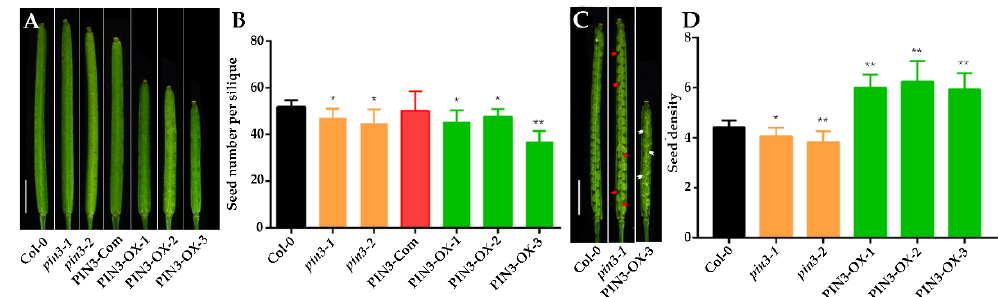
Figure 4. Siliques, seed number per silique (SNS) and seed density (SD) of wild type, pin3 , PIN3-Com (complementation lines) and PIN3-OX (overexpression lines). ( A ) The silique of Col-0, pin3-1 and pin3-2 mutants, PIN3-Com, and PIN3-OXs (Bar = 2mm). ( B ) SNS of Col-0, pin3-1 and pin3-2 mutants, PIN3-Com, and PIN3-OXs. ( C ) Dissected siliques of Col-0, pin3-1 and PIN3-OX-3. Red and white arrows indicate sparsely arranged and crowdedly arranged seed region, respectively (Bar = 2 mm). ( D ) SD of wild type, pin3 and PIN3-OX. “**” indicates statistical significance at p -value < 0.01, “*” indicates statistical significance at p -value < 0.05, p -value determined by Student’s t-test. We also complemented pin3-1 or pin3-2 with a pPIN3::PIN3-GFP construct, and the positive